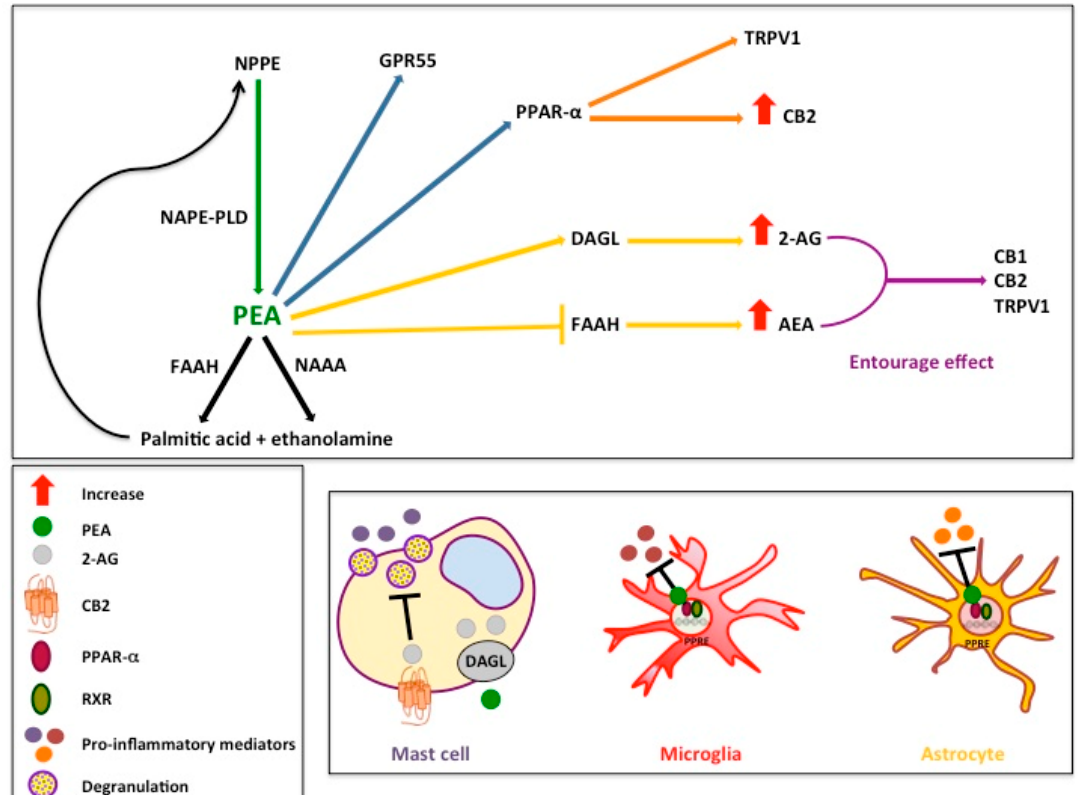
Figure 1. Metabolic pathways and mechanisms of action of PEA. PEA is synthetized by NAPE-PLD (green arrow) and hydrolyzed to palmitic acid and ethanolamine by FAAH and NAAA (black arrows) [28]. PEA directly activates GPR55 [149] and PPAR- α receptors (blue arrows) [148]. PEA activates TRPV1 receptors [145,146] and increases the expression of CB2 receptors (orange arrows) via direct activation of PPAR- α receptors (blue arrow) [154]. PEA, through the stimulation of the activity of DAGL [143] or the inhibition of the expression of FAAH (yellow arrows) [142], increases the endogenous levels of 2-AG and AEA, respectively, which directly activate CB1, CB2, and TRPV1 receptors (“entourage effect”) (violet arrow) [57,142,143,145,146]. PEA, possibly through an allosteric modulation of TRPV1 receptors, potentiates the actions of AEA and 2-AG at TRPV1 receptors (“entourage effect”) [57,145,146]. PEA inhibits the activation of mast cells through an indirect CB2-mediated mechanism (i.e., increased 2-AG synthesis) [140,143]. PEA reduces the activation of microglia and astrocytes through a PPAR- α -mediated mechanism [155,156]. Abbreviations: 2-AG, 2-arachidonoylglycerol; AEA, anandamide; CB1, type-1 cannabinoid receptors; CB2, type-2 cannabinoid receptors; DAGL, diacylglycerol lipase; FAAH, fatty acid amide hydrolase; GPR55, G-protein coupled receptor 55; NAAA, N -acylethanolamide hydrolyzing acid amidase; NAPE-PLD, N -acyl-phosphatidyl-ethanolamine-selective phospholipase D; PEA, palmitoylethanolamide; PPAR- α , peroxisome proliferator-activated receptor- α ; TRPV1, transient receptor potential vanilloid type-1.